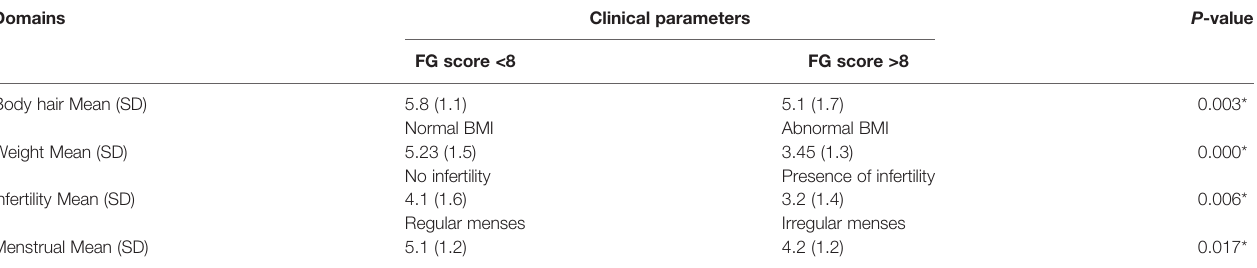
TABLE 4 | Mal-PCOSQ domain with different clinical parameters.